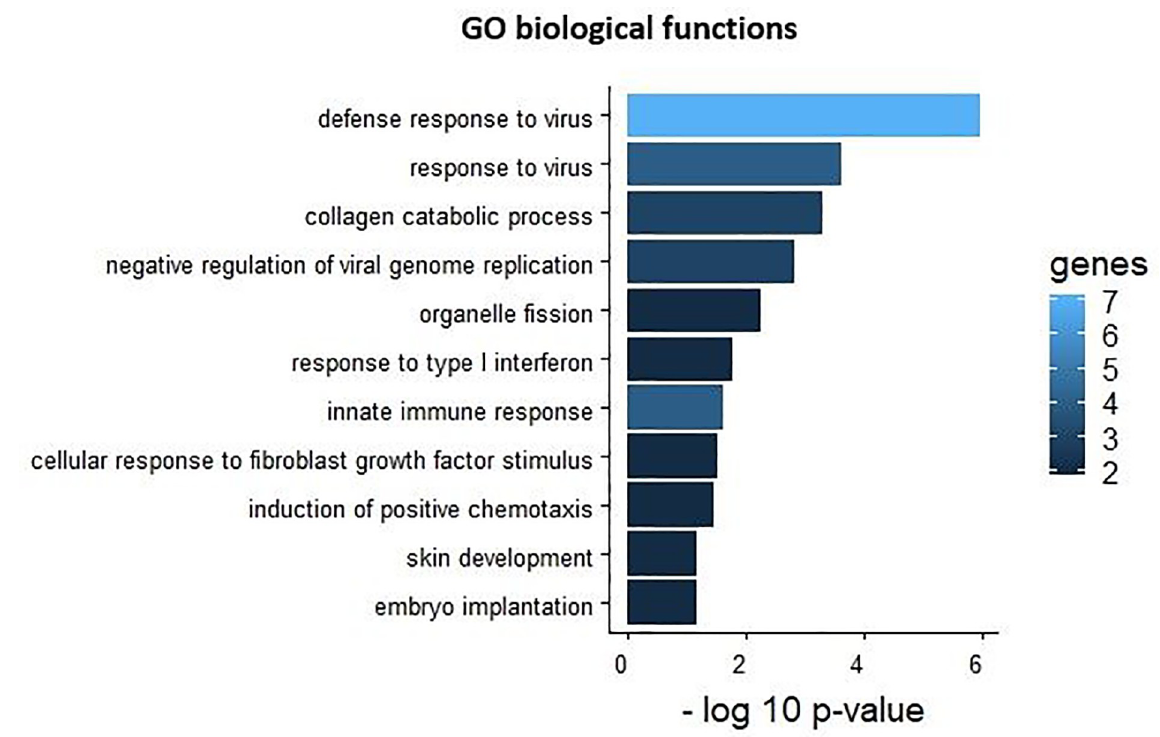
Fig 4. Functional enrichment of differentially expressed genes. Most significant GO terms associated with down and upregulated genes. The bar length indicates the significance and equals to the negative logarithm of the p-value. The bar color indicates the number of genes of that pathway that are differentially expressed in MAC-T BLV